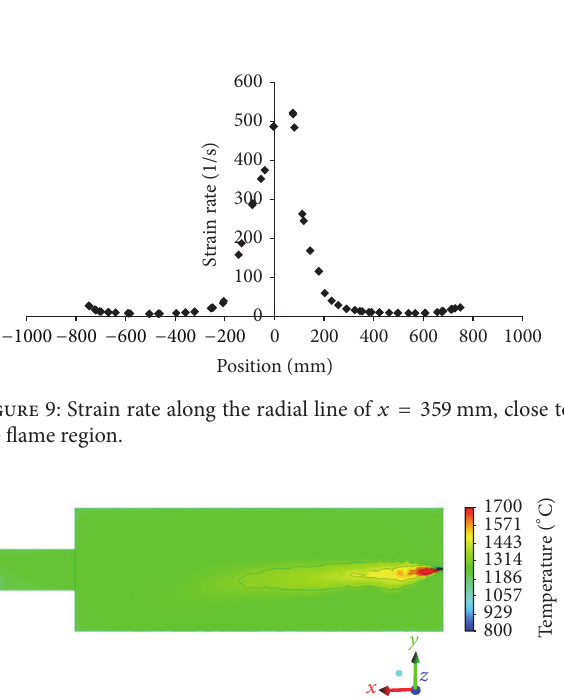
Figure 10: Temperature distribution profile on the 𝑥 - 𝑦 plane in the middle of the chamber, model 1.